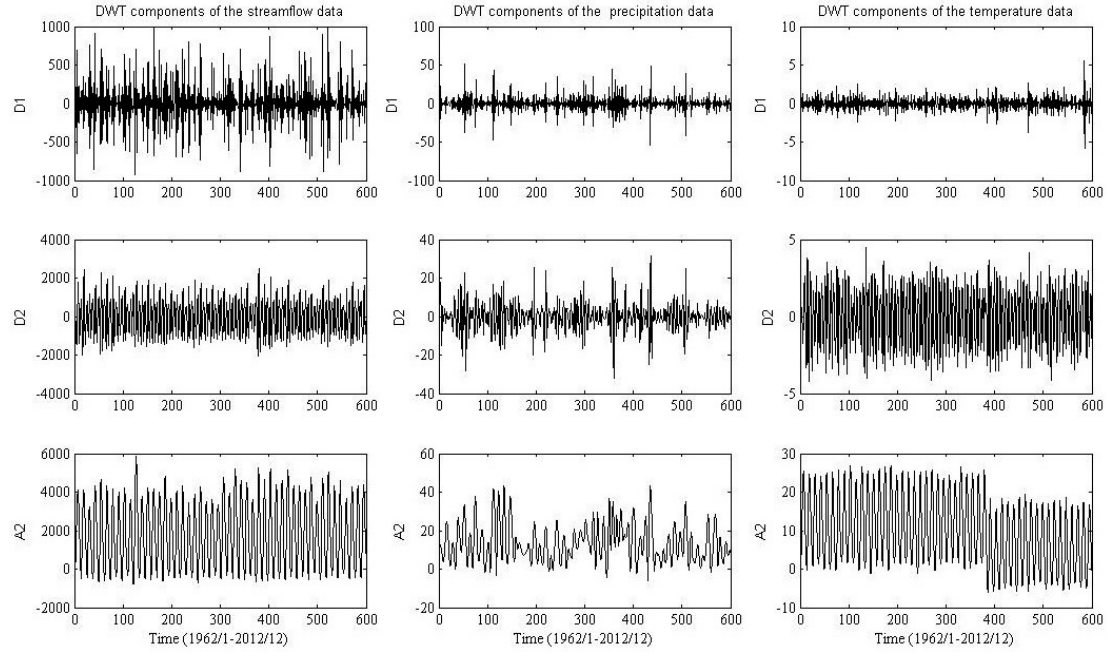
Figure 4. Zone One: streamflow, precipitation, and temperature data are decomposed by DWT.